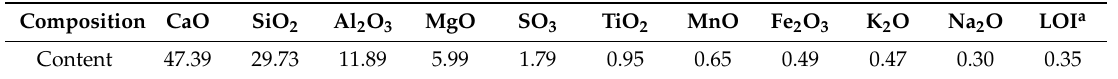
Table 1. Chemical composition of slag (mass %).